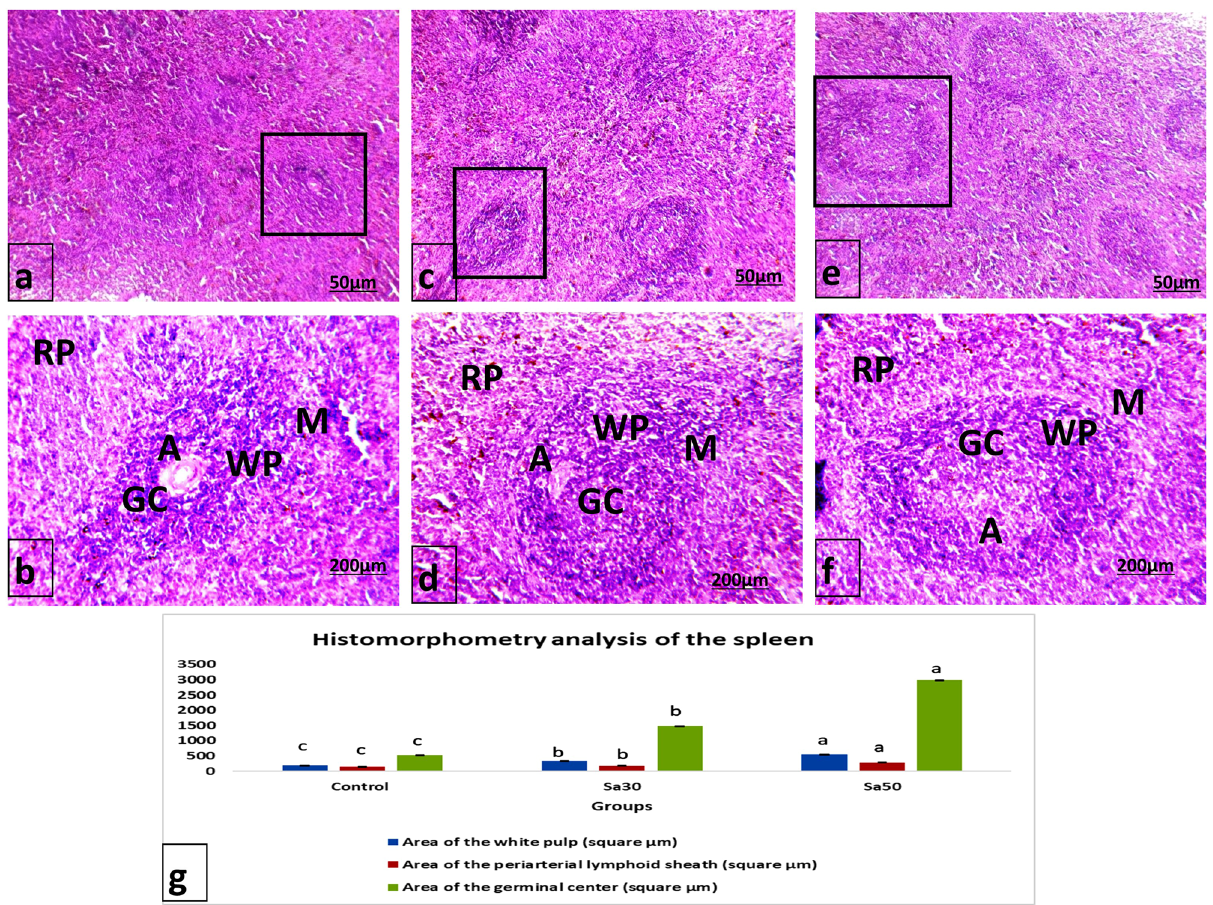
Figure 1. Photomicrograph of ( a & b ) the spleen from a control rat, ( c&d ) the spleen of a rat in the Sa30 group, and ( e & f ) the spleen from a rat in the Sa50 group showing marked histopathological changes in the spleen spleens of rats treated with Nigella sativa seeds. Different superscript letters represent significant differences at P <